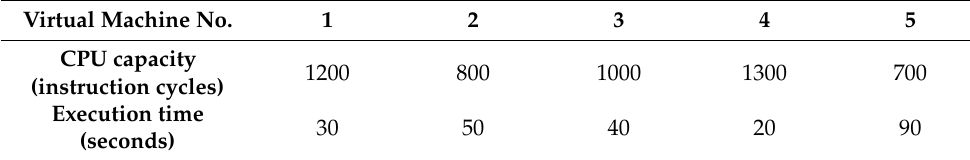
Table 5. Configuration of 5 virtual machines for scenario 3.